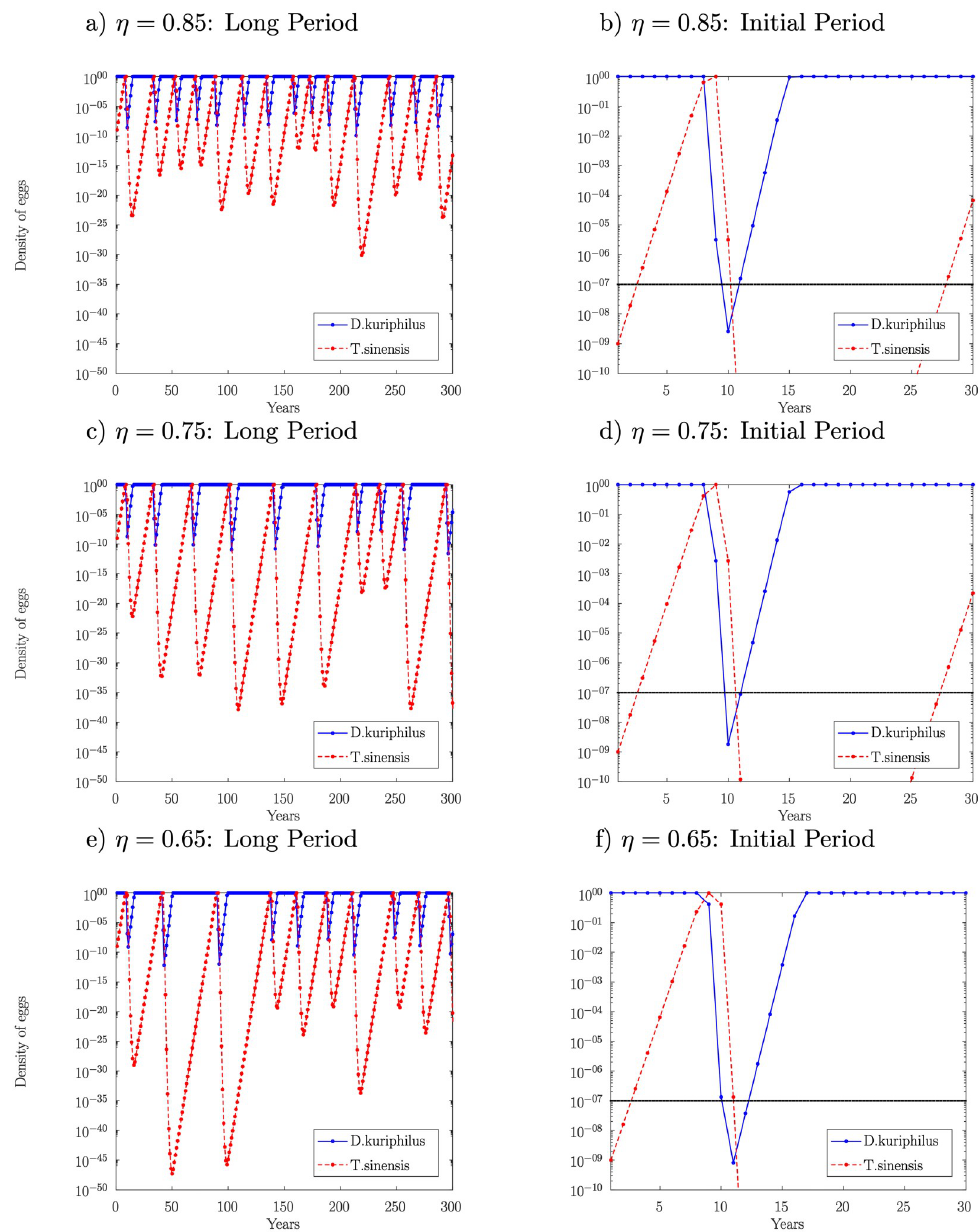
Fig 4. Temporal evolution of the egg density in function of the overwintering survival rate of D . kuriphilus . A logarithmic scale is used to highlight the low density reached by the two insect species.